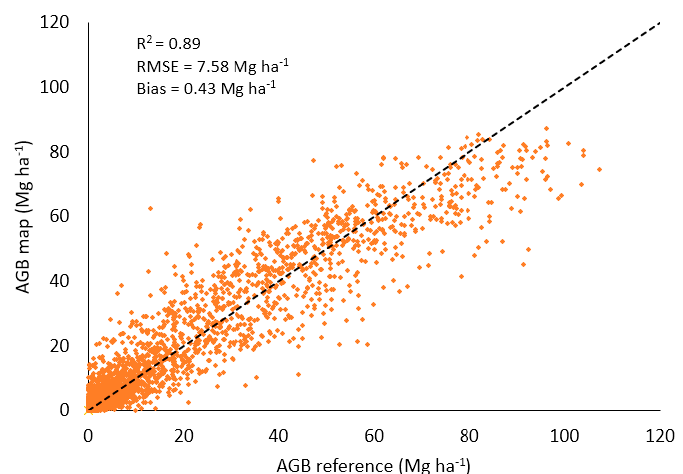
Figure 6. Cross-validation between the AGB map predictions and AGB reference data derived from the LiDAR point clouds. The black dash line corresponds to the y = x line. RMSE: root mean square error.